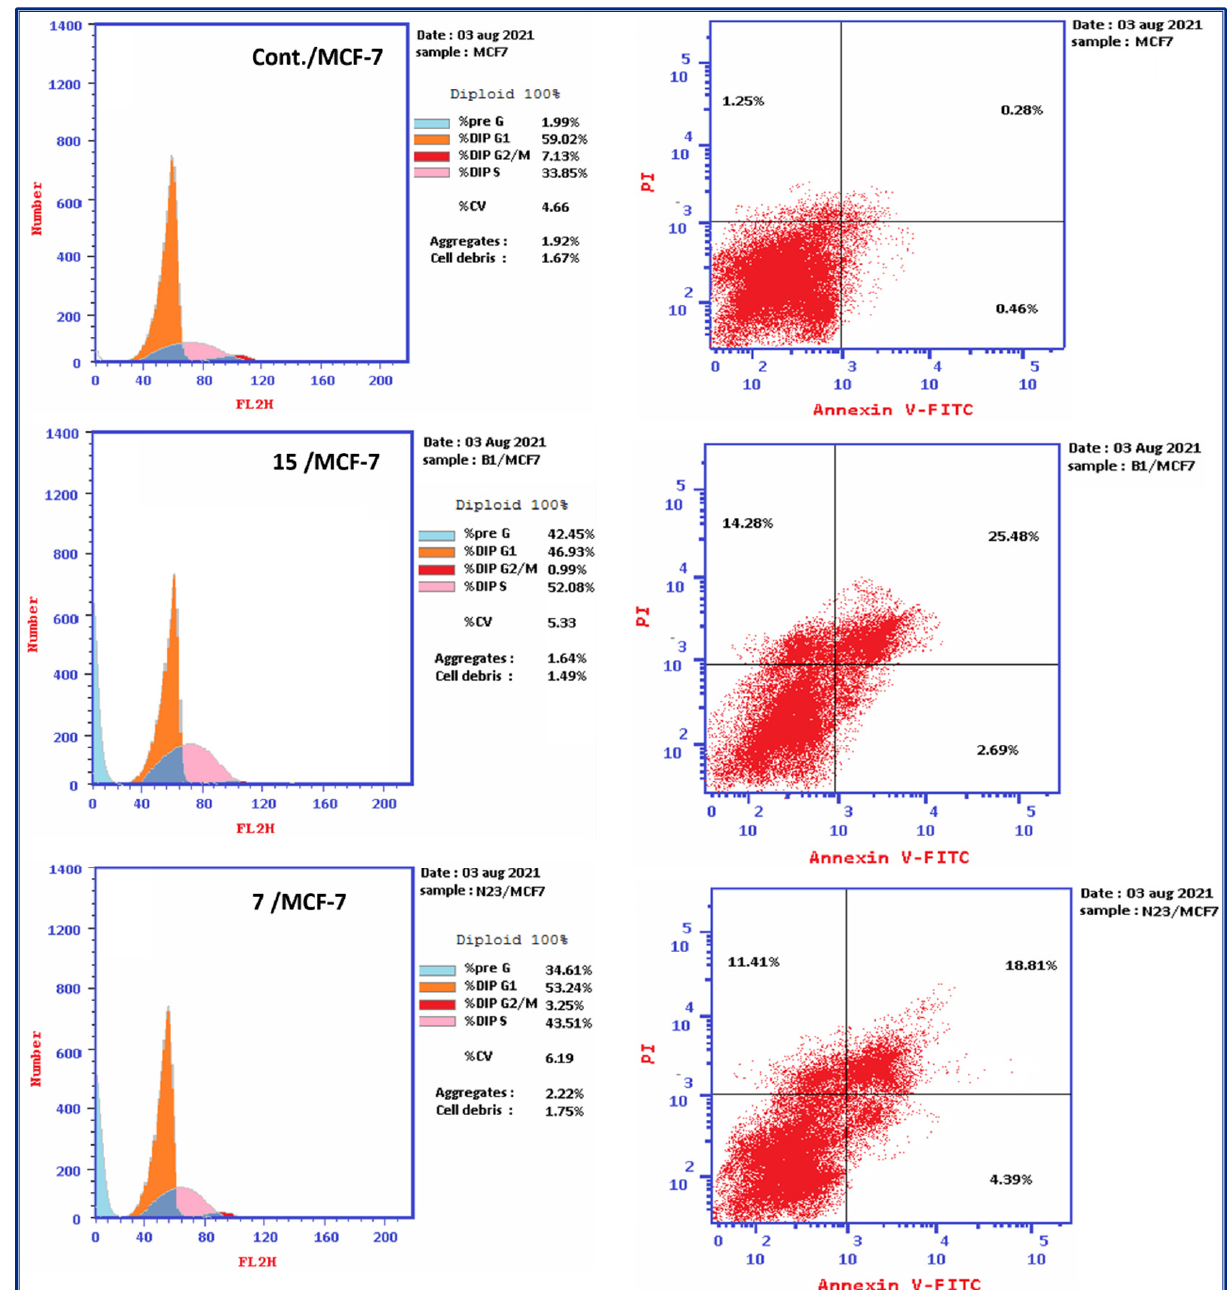
Figure 3. Analysis of the cell cycle and the effect of derivatives 7 and 15 on the percentage of annexin V-FITC-positive staining in MCF-7 cells in comparison with the control.